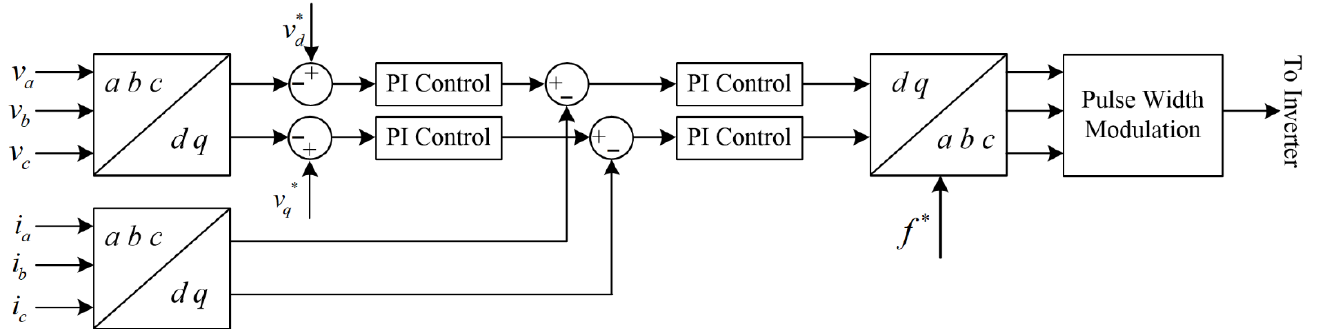
Figure 12. Control structure of the voltage source inverter with the newly obtained voltage setpoints.